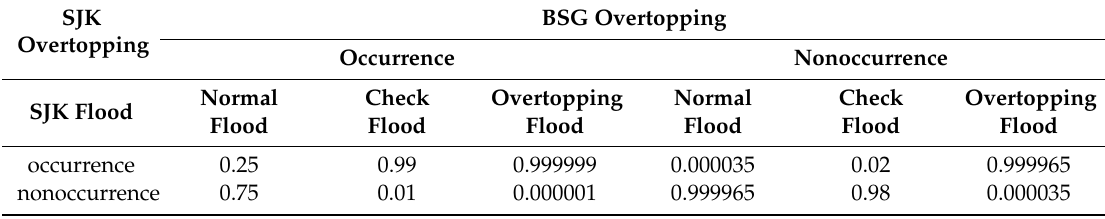
Table 11. The probability of SJK Overtopping on the condition of BSG Overtopping and SJK